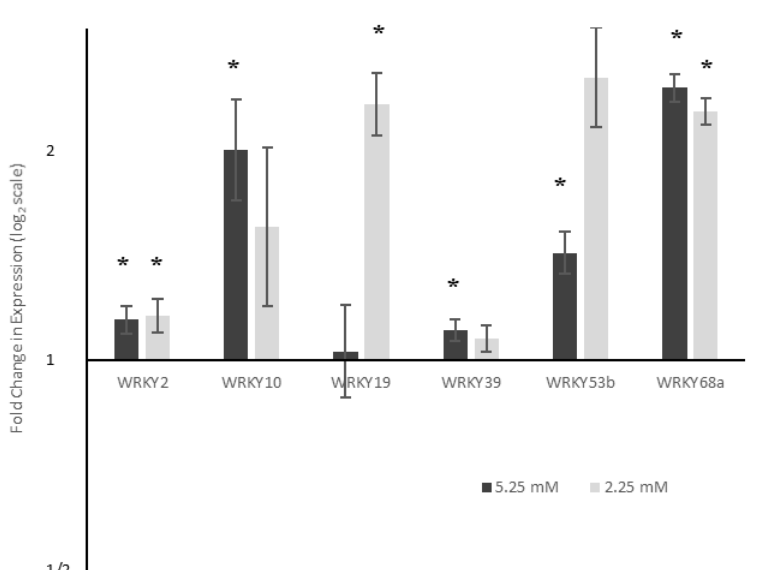
Figure 2. Expression of six WRKY transcription factors under reduced nitrogen availability. Gene expression is shown relative to expression levels when grown under 7.5 mM NO 3 − . ∆∆ C T values were analysed using ANOVA followed by Tukey post-hoc, n = 3. * p < 0.05. Expression of all WRKYs was significantly ( p < 0.05) upregulated under at least one reduced nitrogen condition.